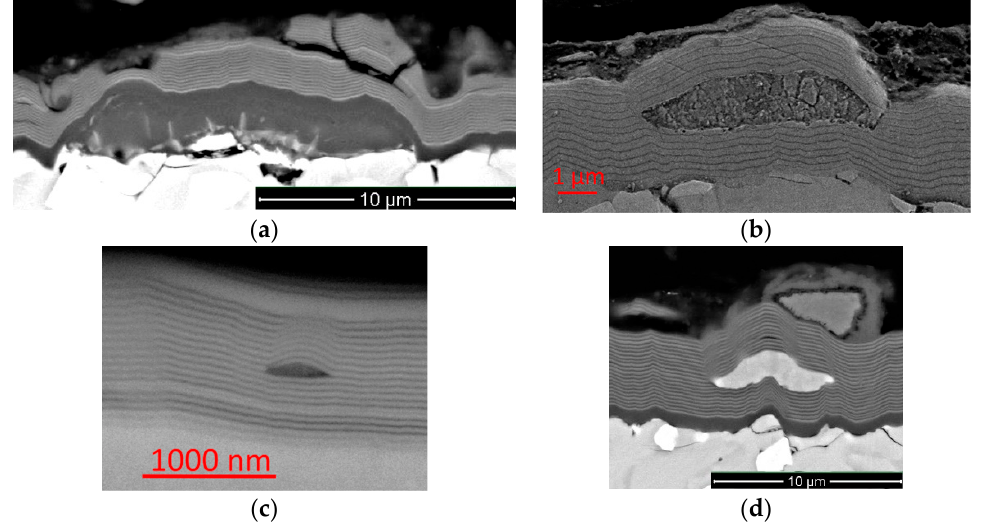
Figure 5. Examples of the influence of microdroplets on the structure of ( a , b ) Ti–TiN–(Ti,Nb,Zr,Al)N and ( c , d ) Ti–TiN–(Ti,Cr,Mo,Al)N coatings ( a , c , and d —SEM 1, b —SEM 2).